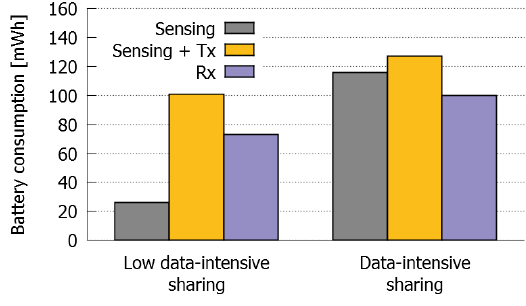
Figure 17. Comparison of the energy costs of high data-intensive and low data-intensive sharing processes.